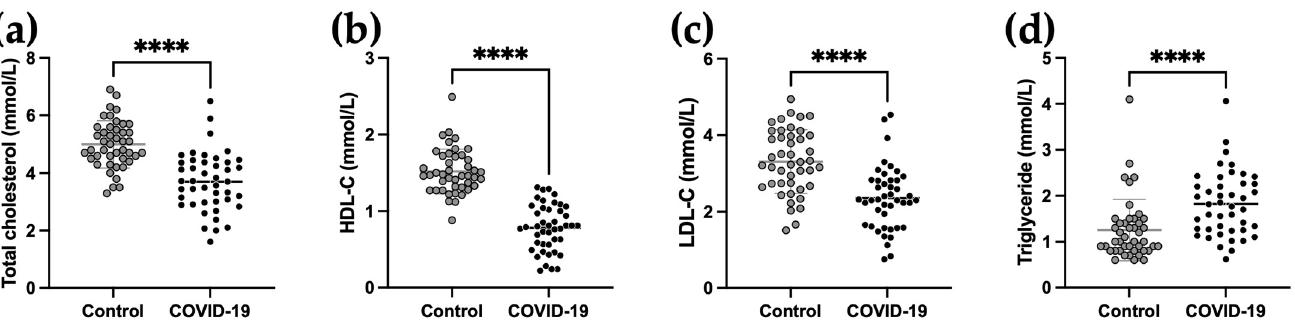
Figure 1. Lipid profile changes in plasma of COVID-19 ICU patients. Plasma levels of total cholesterol ( a ), HDL-cholesterol (HDL-C) ( b ), LDL-cholesterol (LDL-C) ( c ) and triglycerides ( d ) were measured